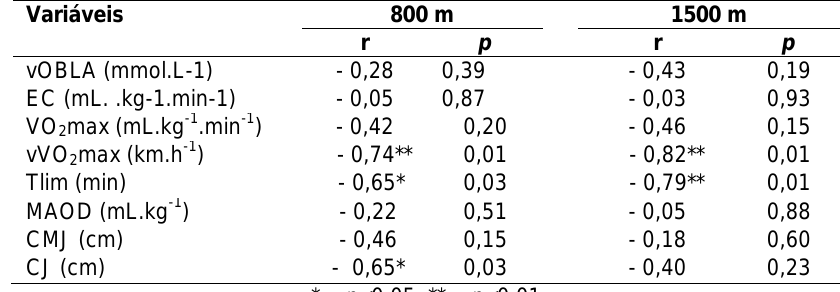
Tabela 3. Valores de correlação dos índices fisiológicos e neuromusculares com a performance nas distâncias analisadas.